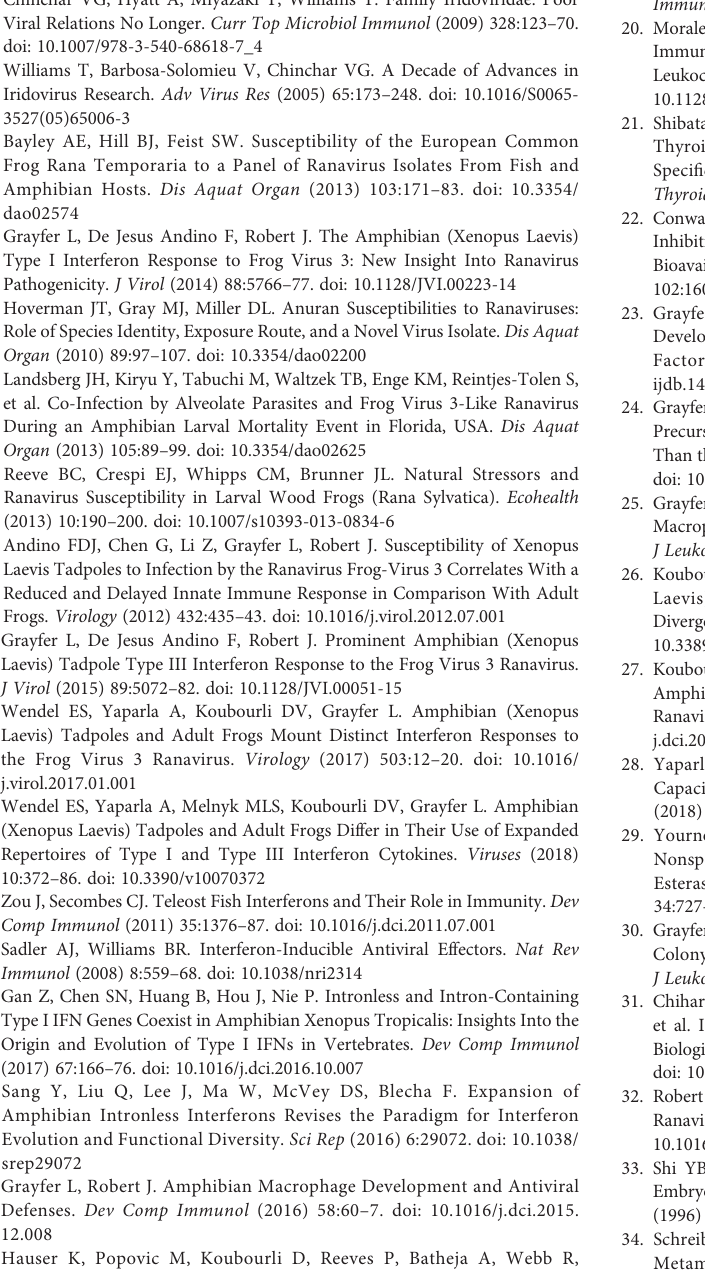
Asterisksabovelines( ∗ )denotestatisticaldifferencesbetweenthetreatmentgroups denoted by the lines, p <0.05. Supplementary Figure 3 | Comparison of antiviral gene expression in the intestines of tadpoles (stage NF 54), metamorphic (stage NF 62) and adult frogs. Results are means ± SE of gene expression relative to gapdh endogenous control ( N =6). Asterisk ( ∗ ) denotes statistical difference from tadpole expression, p